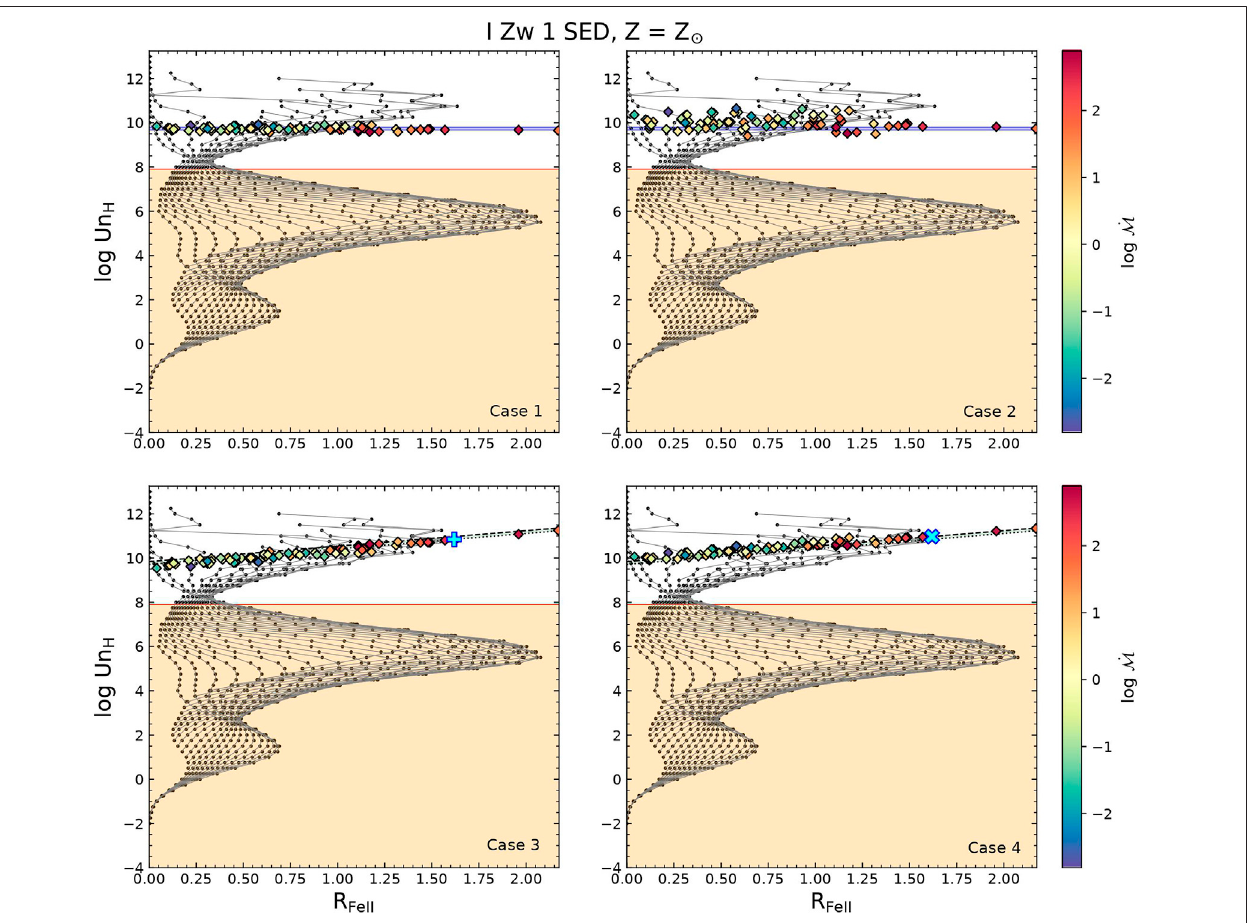
FIGURE7| Similartothelastpanel(Case4)in Figure6 .Here,wecompareIZw1modelsat3Z ⊙ ,at3Z ⊙ withanadditionalmicroturbulentvelocity20 km s − 1 ,andat 10Z ⊙ . The location of the respective sources ismarked using a blue cross in the corresponding panels. The red plus symbol on the right panel marks the position of the value obtained for Un H using the fi ltering of EWs (see Section 4.3